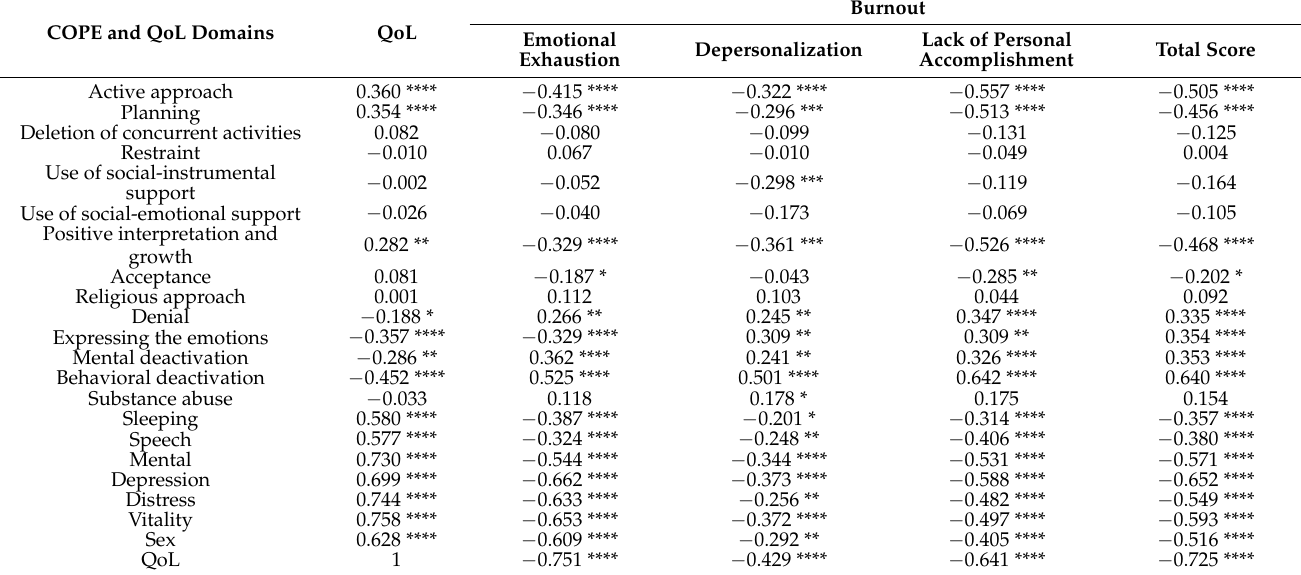
Table 4. Correlations between the burnout dimensions and COPE/QoL